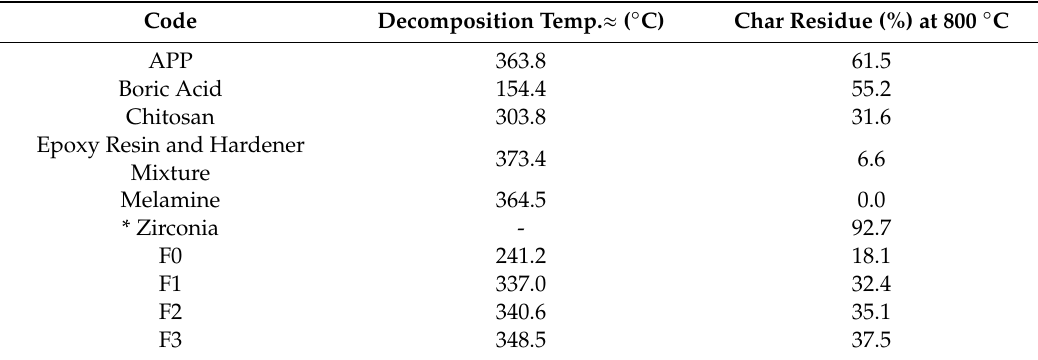
Table 4. Thermal stability results of the flame retardant components and formulation